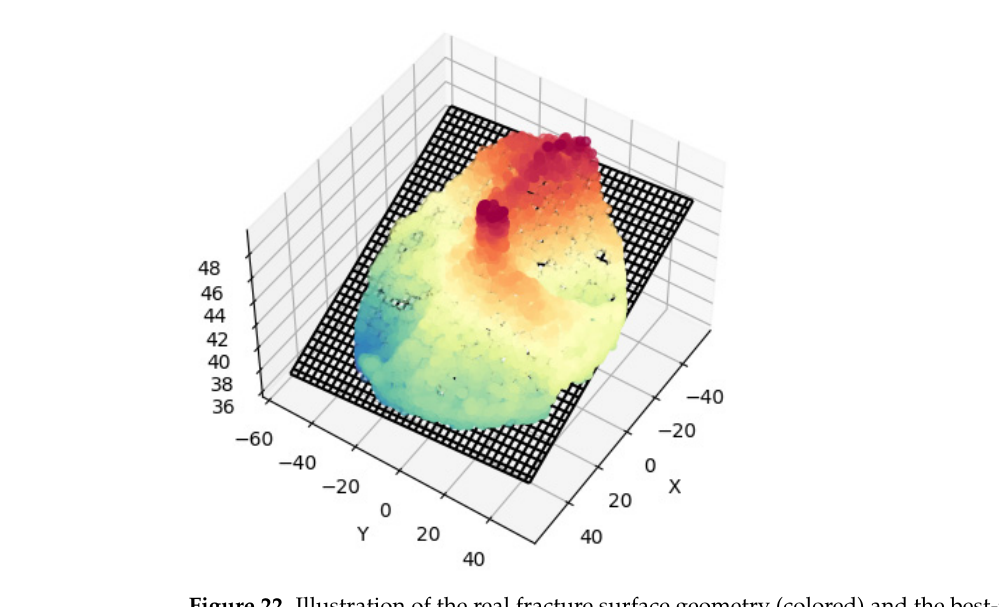
Figure 22. Illustration of the real fracture surface geometry (colored) and the best-fit plane (black). Table 6. Statistical surface roughness parameters of selected samples (Equations